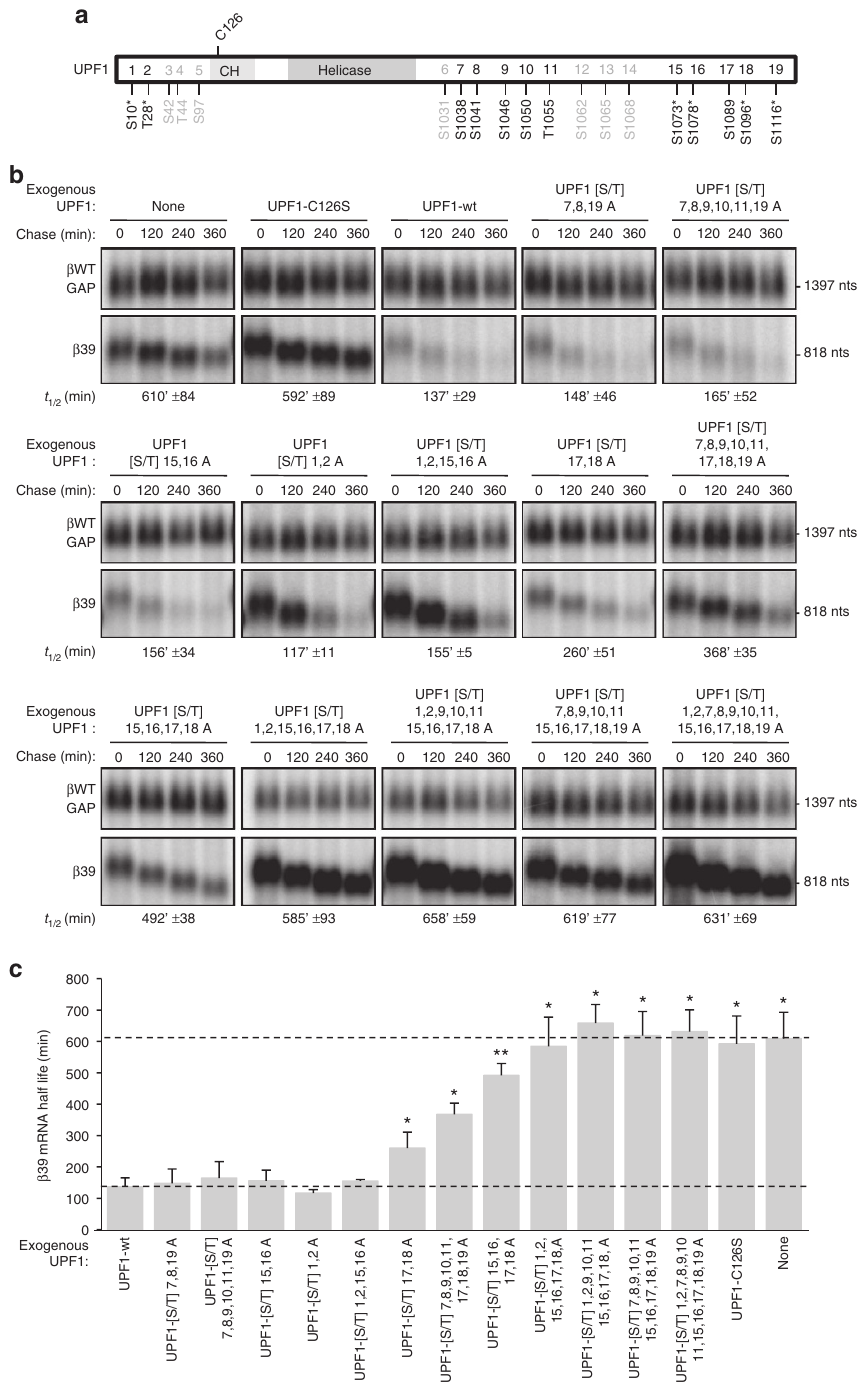
NATURE COMMUNICATIONS|7:12434|DOI: